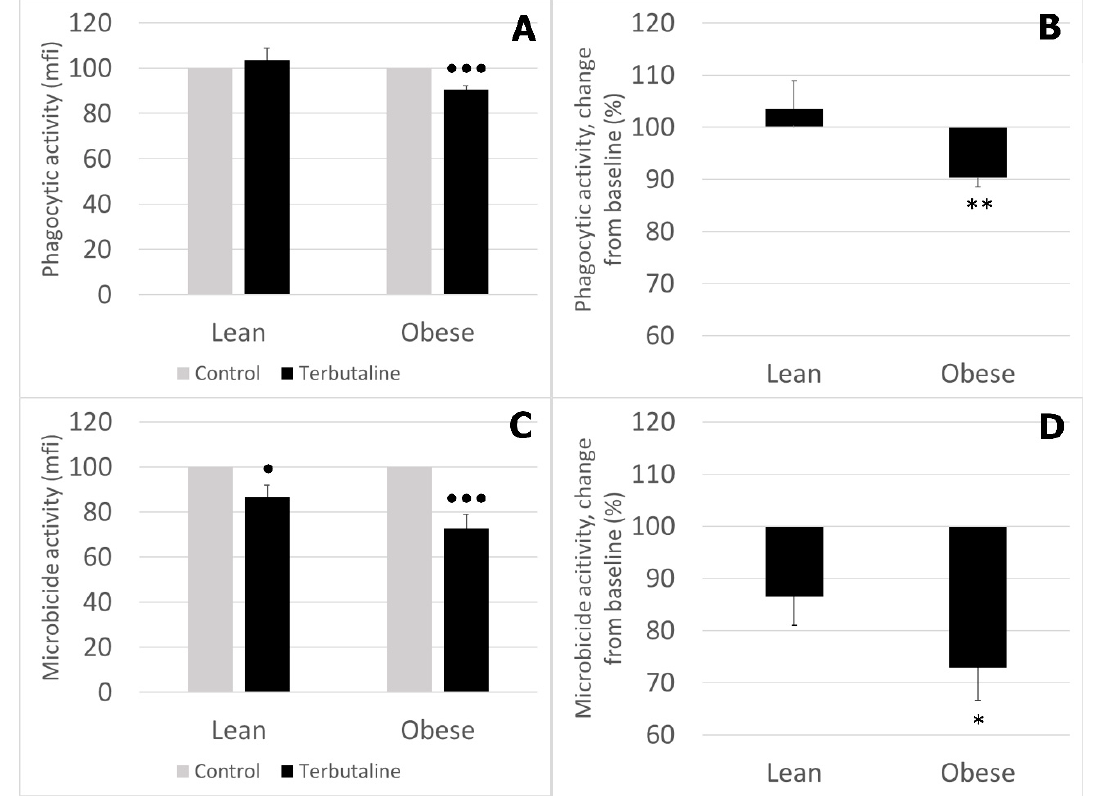
Figure 2. Effect of β 2 adrenergic agonist terbutaline on ( A, B ) phagocytic and ( C, D ) microbicide activity of circulating monocytes from lean and obese mice, expressed as the percentage change from baseline (giving “100” to control values in the absence of terbutaline). Columns represent the mean ± SEM of independent assays performed in duplicate. * p < 0.05 and ** p < 0.01 vs. corresponding lean value; • p < 0.05 and ●●● p < 0.001 vs. corresponding control value. Table 2. Effect of β 2 adrenergic agonist terbutaline and β 2 adrenergic antagonist butaxamine on percentage of phagocytic monocytes and percentage of microbicidal monocytes from lean and obese mice. Terbutaline + Control Terbutaline Butaxamine Phagocytic percentage (%)